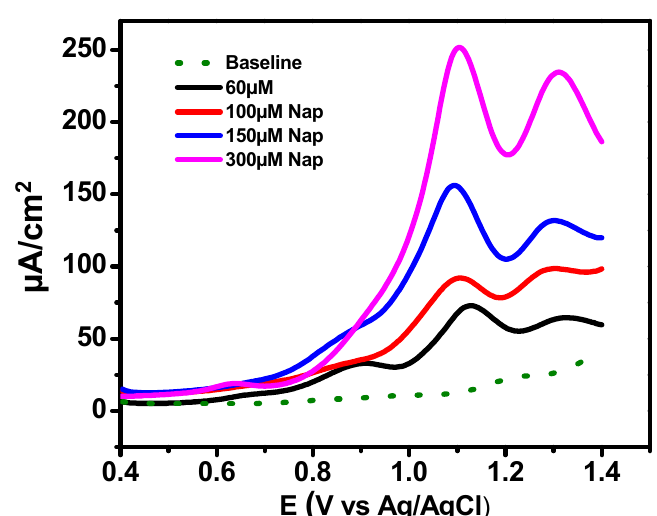
Figure 8. DPV responses showing the detection of 30 µ M, 100 µ M, 150 µ M, and 300 µ M naproxen.